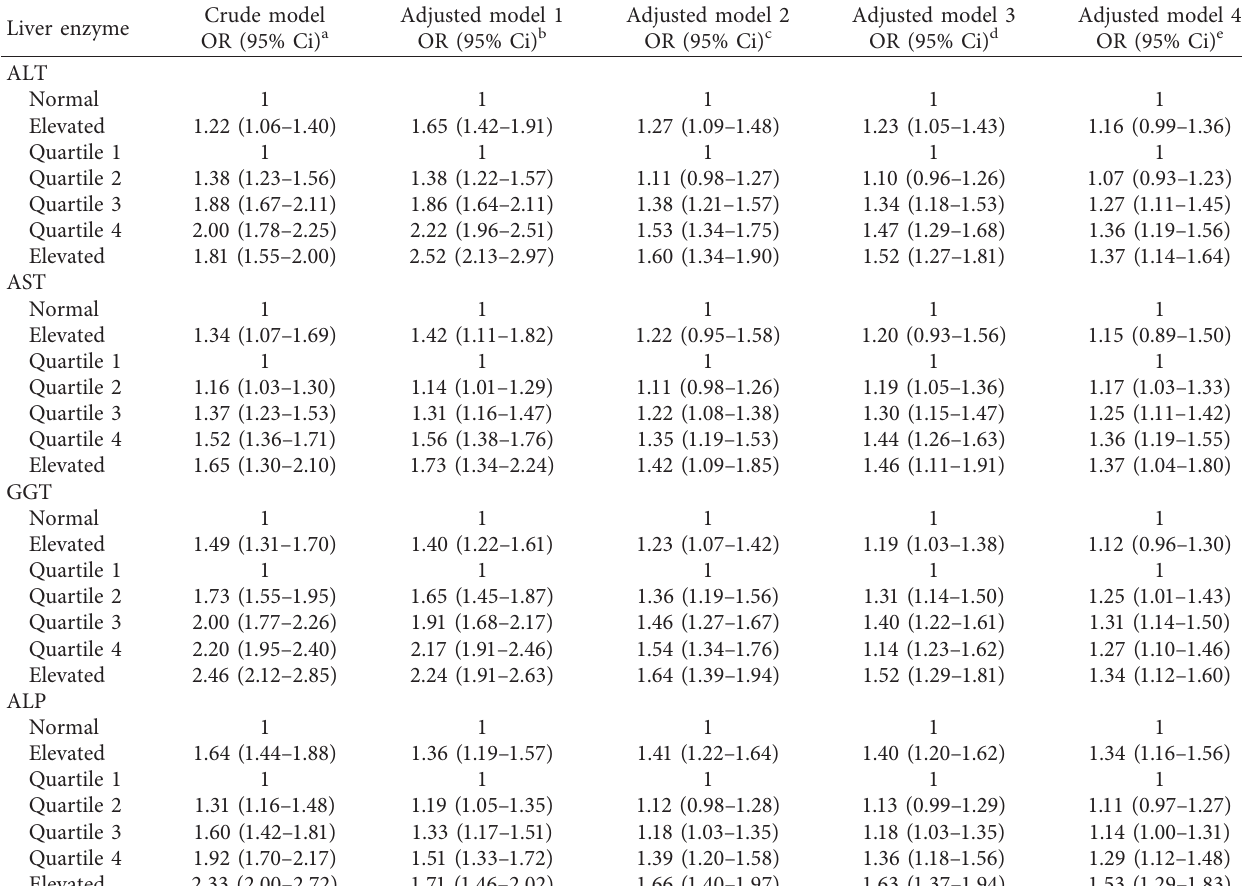
Table 4: Association of the serum levels of liver enzymes with abnormal blood pressure in study participants ( n �